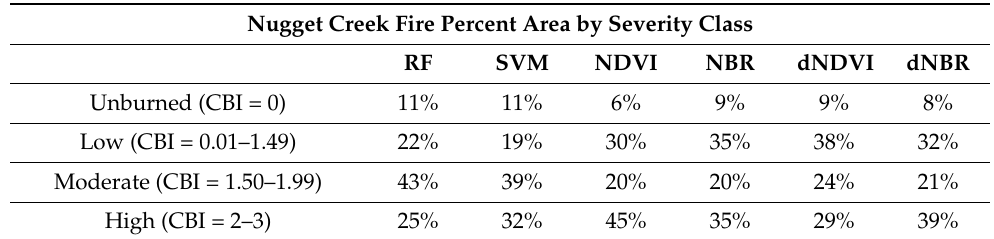
Table 6. Percent area of each burn severity class by product for the Nugget Creek fire.